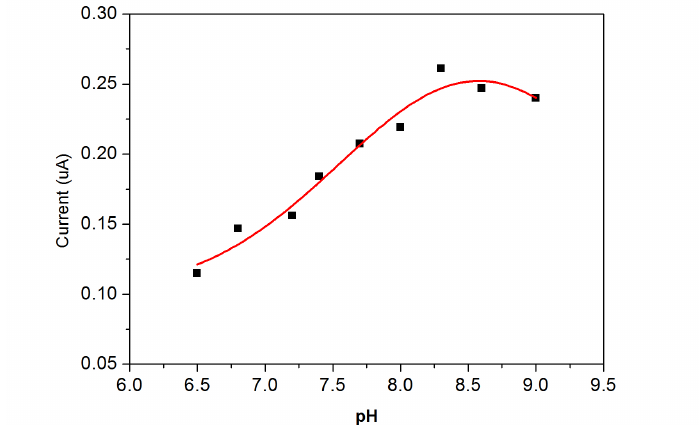
Figure 4. The influence of pH on the response of the disposable biosensor at +0.5 V in the presence of DG (30 µM) in 0.1 M phosphate